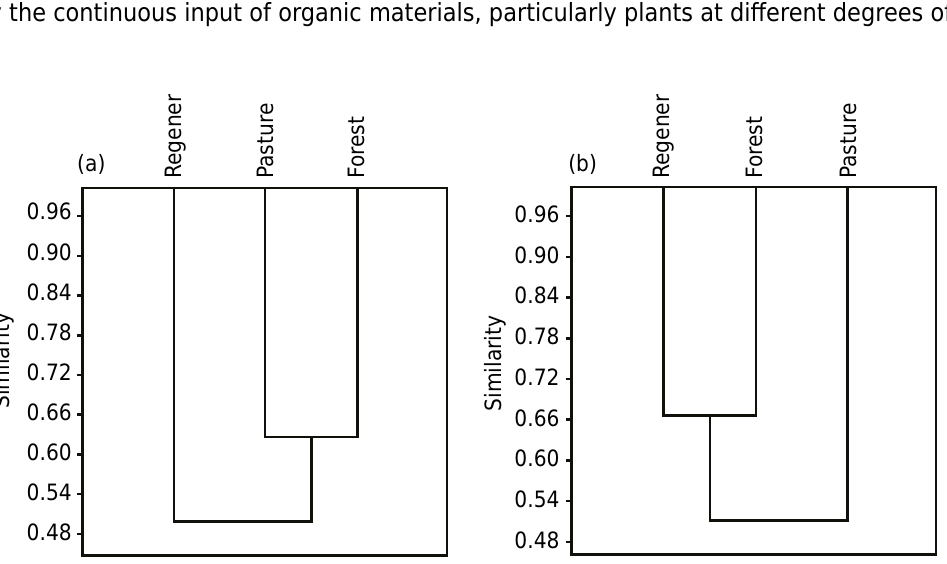
Figure 1. Dendrogram showing the frequency of arbuscular mycorrhizal fungi species in topsoil (0.00-0.05 m) from areas of natural regeneration (Regener.), natural pasture, and a fragment of native forest on the Palmital farm in Passa Vinte, MG, Brazil, sampled in the dry (a) and rainy (b) season (Jaccard similarity index was used)